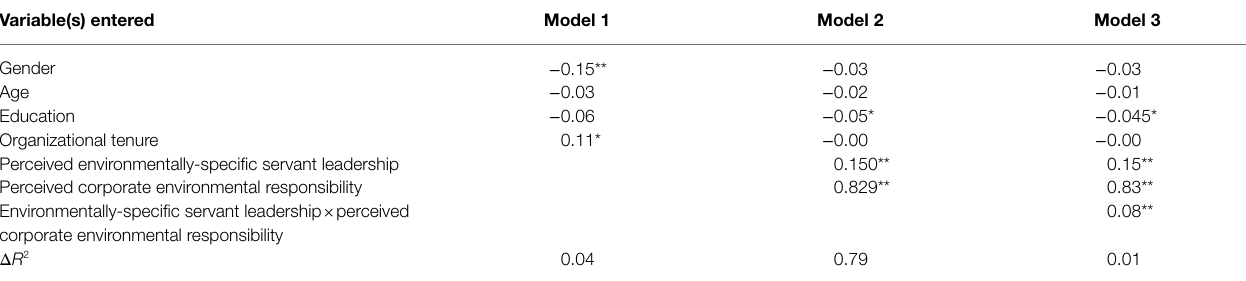
TABLE 4 | Results of moderated multiple regression analysis for employees’ green role identity. Variable(s) entered